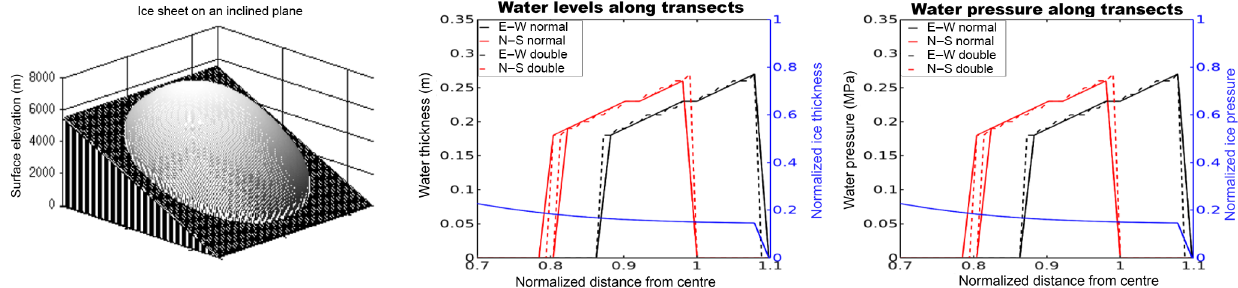
Figure 3. Plots of the bell-shaped ice sheet on an inclined plane. This series also tests the convergence of the model. “Normal” refers to the model using the same resolution as the previous tests and “double” refers to the tests that has twice the resolution (finer) grid than the other tests.